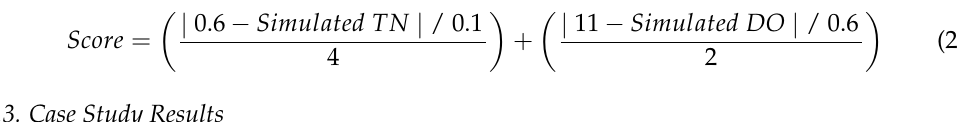
Figure A4 in Appendix A: (1) id—Each EDSS execution has a unique string; (2) status—This field is changed from “RUNNING” to “COMPLETED” once the EDSS publishes the results; (3) result—This shows the results of the best run. In this case, as two recursive runs were defined, we can see two sets of results with different identification strings ( best_run ). The first is for the search between 0.2 m 3 /s and 0.8 m 3 /s with 0.1 m 3 /s interval, in which a flow of 0.6 m 3 /s ( params ) had the best relative score of 0.525 out of the seven runs. The second results are for the run between 0.55 m 3 /sec and 0.65 m 3 /s with a 0.01 m 3 /s